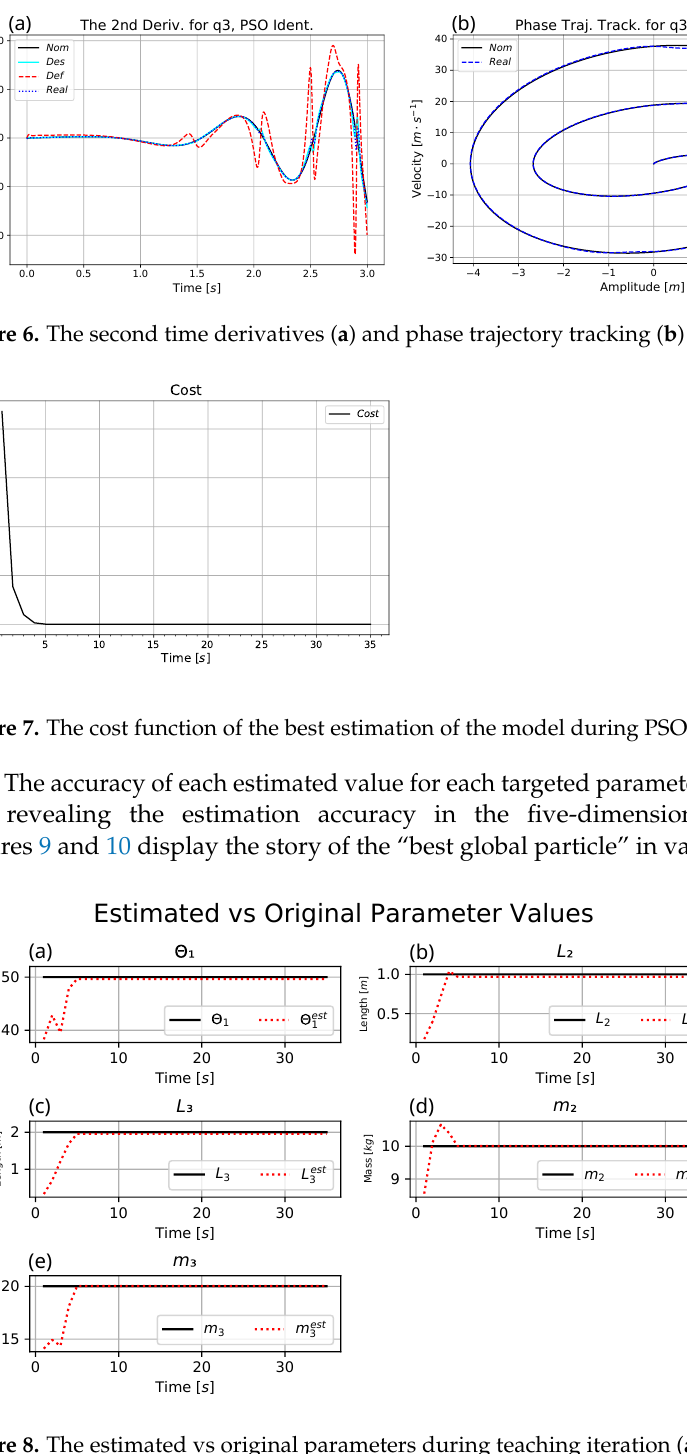
Figure 8. The estimated vs original parameters during teaching iteration ( a ) for Θ 1 ( b ) for L 2 ( c ) for L 3 ( d ) for m 2 ( e ) for m 3